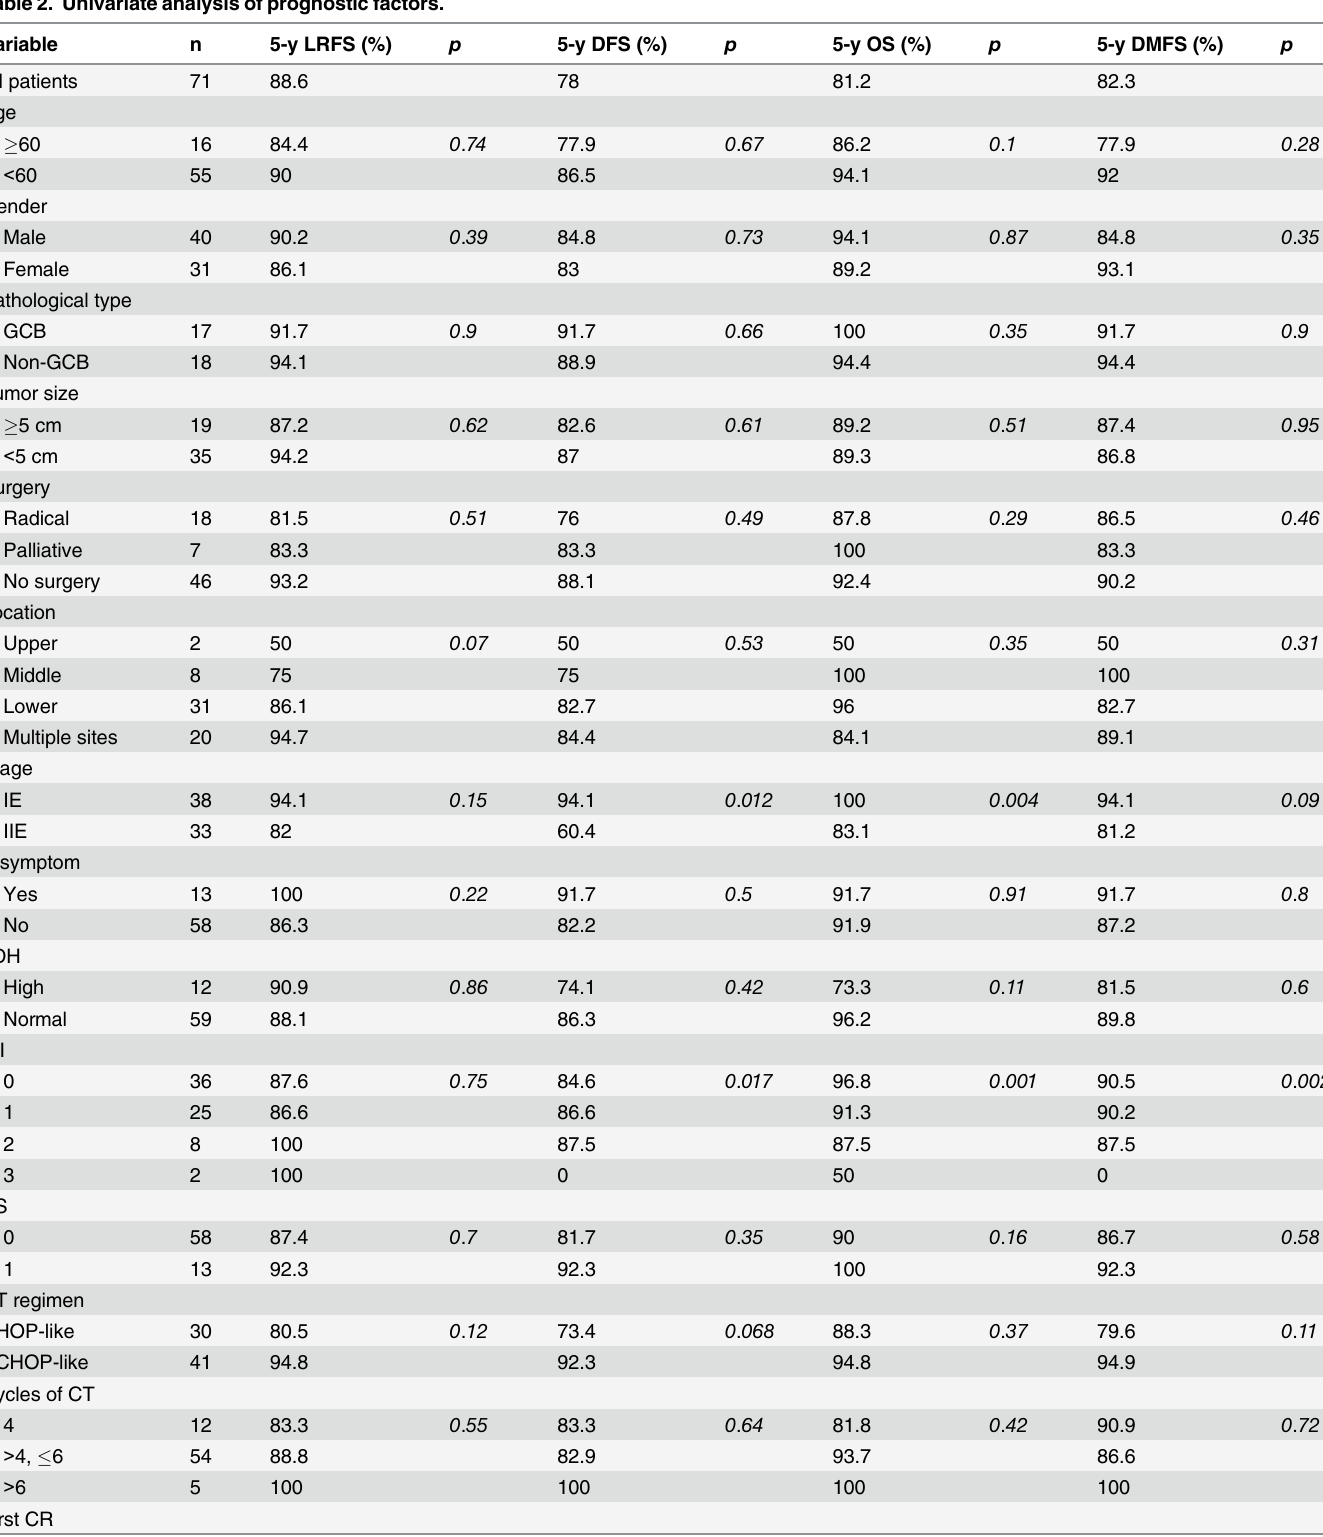
Table 2. Univariate analysis of prognostic